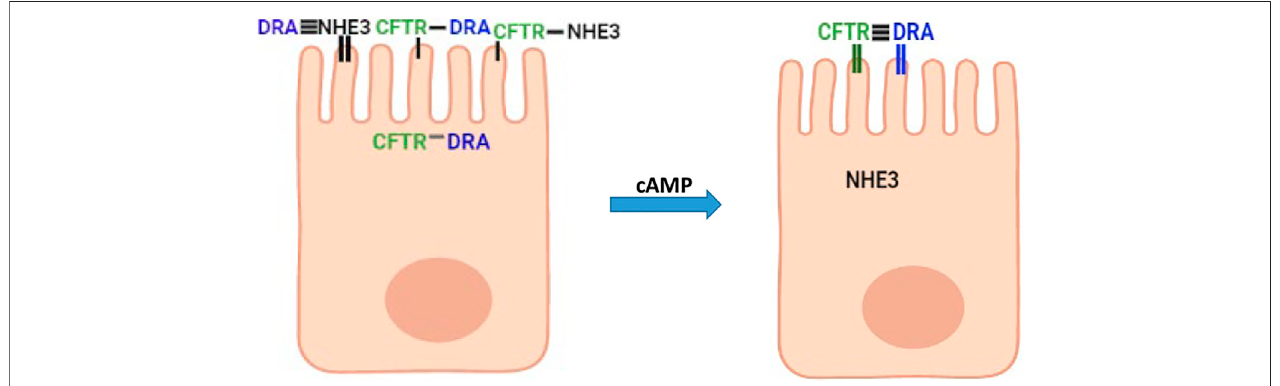
FIGURE 7 | Suggested model in partially differentiated enterocytes of interactions of NHE3, DRA, and CFTR under baseline conditions and after cAMP. Horizontal lines connecting NHE3, DRA, and CFTR above microvilli indicate the extent of physical interaction (the more the horizontal lines, the greater the physical interaction). Vertical lines in microvilli associated with each protein indicate the percent of the total protein in the apical membrane (thick line high